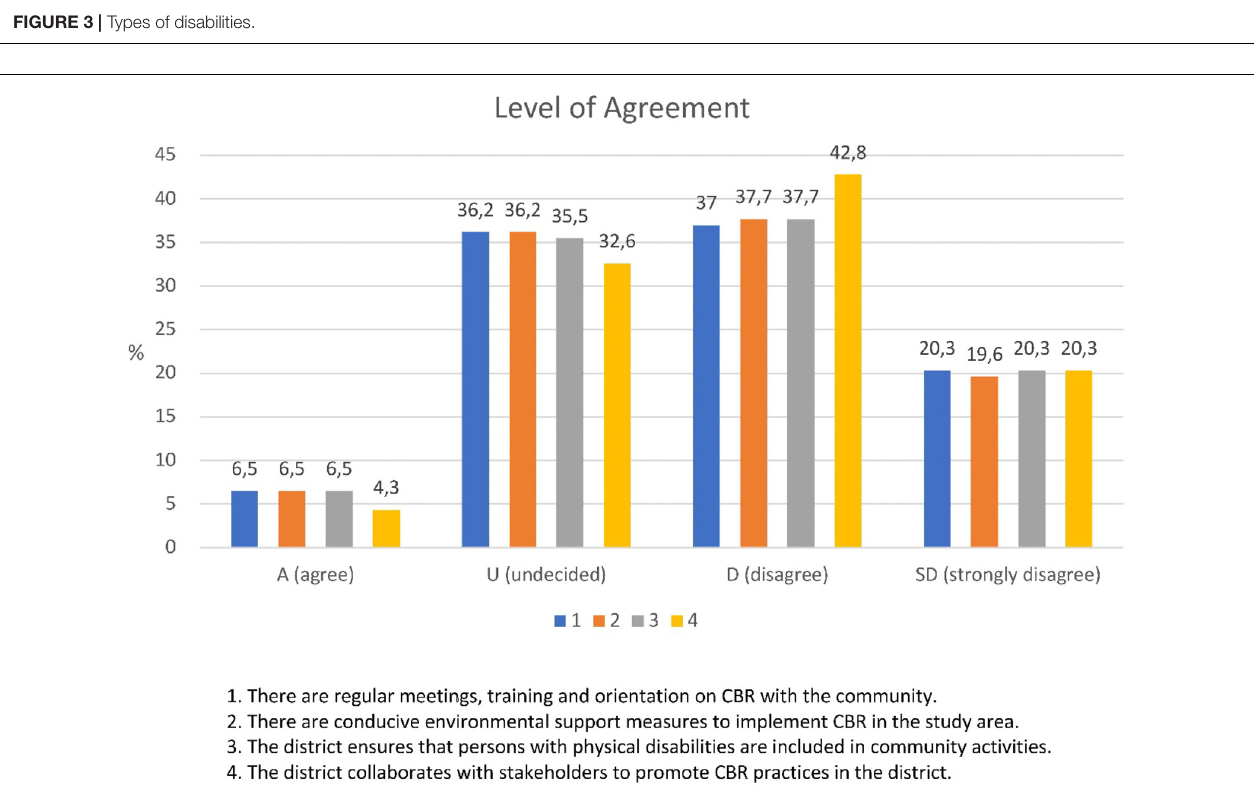
FIGURE 4 | Provision of CBR services in the community.